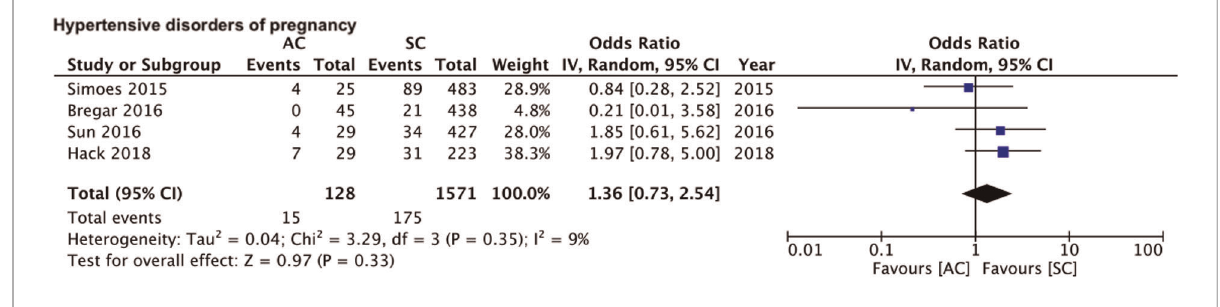
FIGURE 2 Meta-analysis of HDP between assisted and spontaneously conceived monochorionic twin